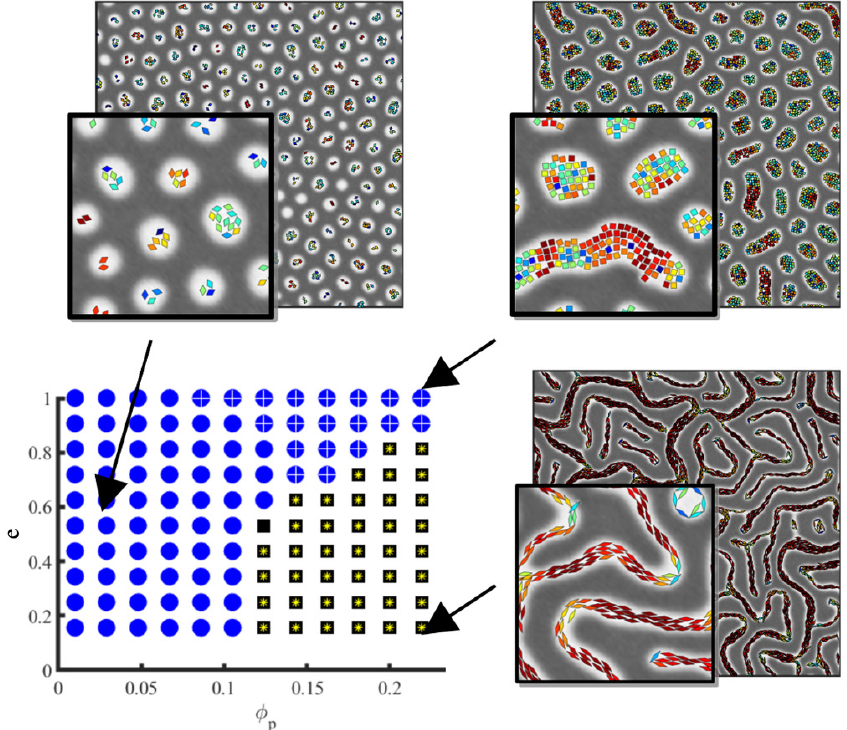
Figure 17. BCP phase behavior depending on the NP anisotropy from squares ( e = 1) to rhomboids ( e = 0.2), and a volume fraction φ p of particles. The BCP phase is marked as blue squares for circular morphology and black squares for lamellar phase. The colloid–colloid alignment is marked by a yellow asterisk for simulations with high twofold nematic order S cc and white crosses for low twofold nematic order but high fourfold tetratic order S 4 cc . NPs are colored according to their local nematic ordering. Reprinted with permission from Ref. [170] Copyright 2022